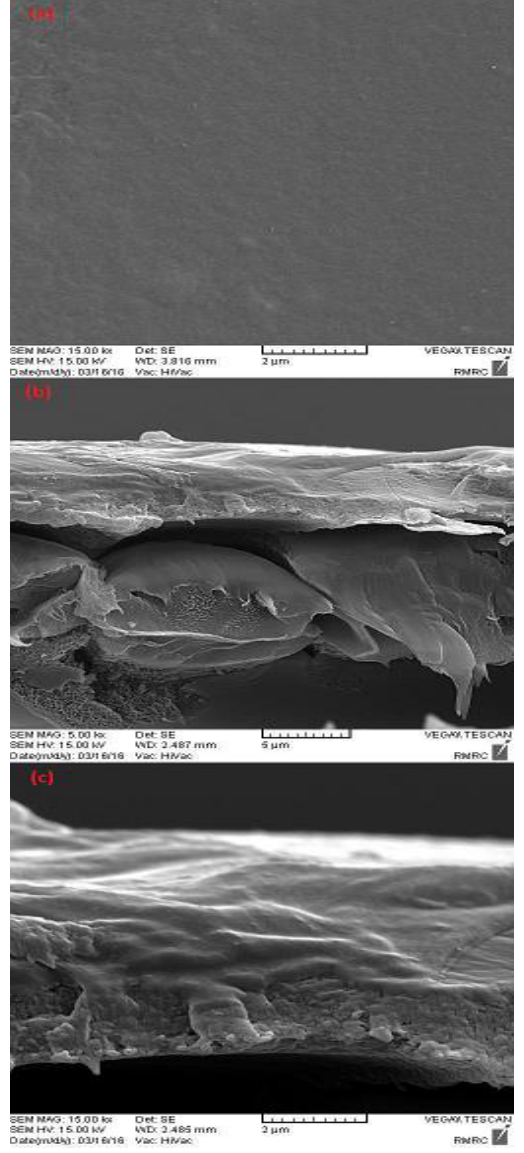
Fig. 4. SEM of the top surface of the PEBA1 composite membrane (a), the cross-sectional SEM image of PEBA/ PAN layers (b), and a closer cross-sectional SEM image of PEBA layer of the PEBA1 composite membrane